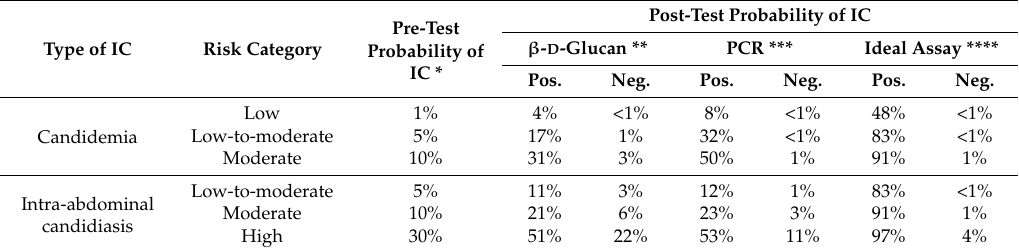
Table 2. Performance of non-culture tests for invasive candidiasis in various